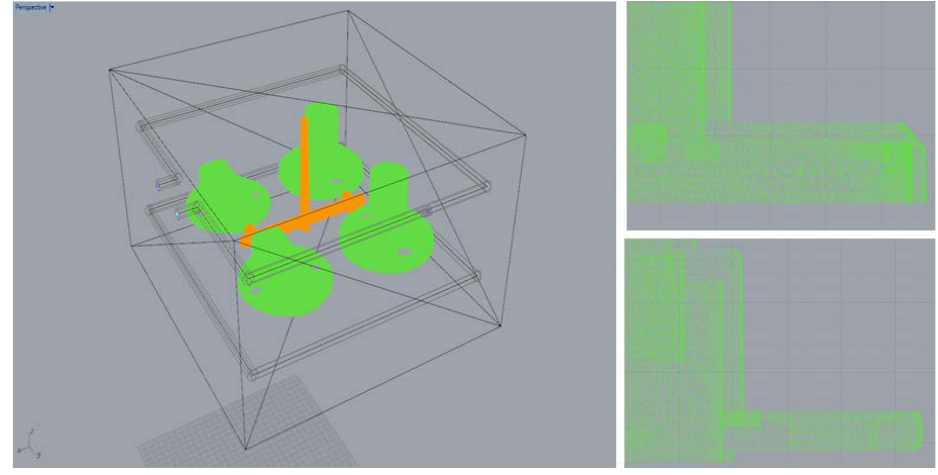
Figure 2. Mesh Figure of a Car Lock Part.